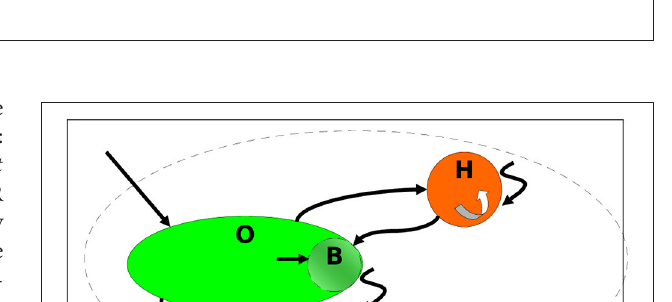
FIGURE 5 | The closed-system model extended to out-of-earth reservoirs.